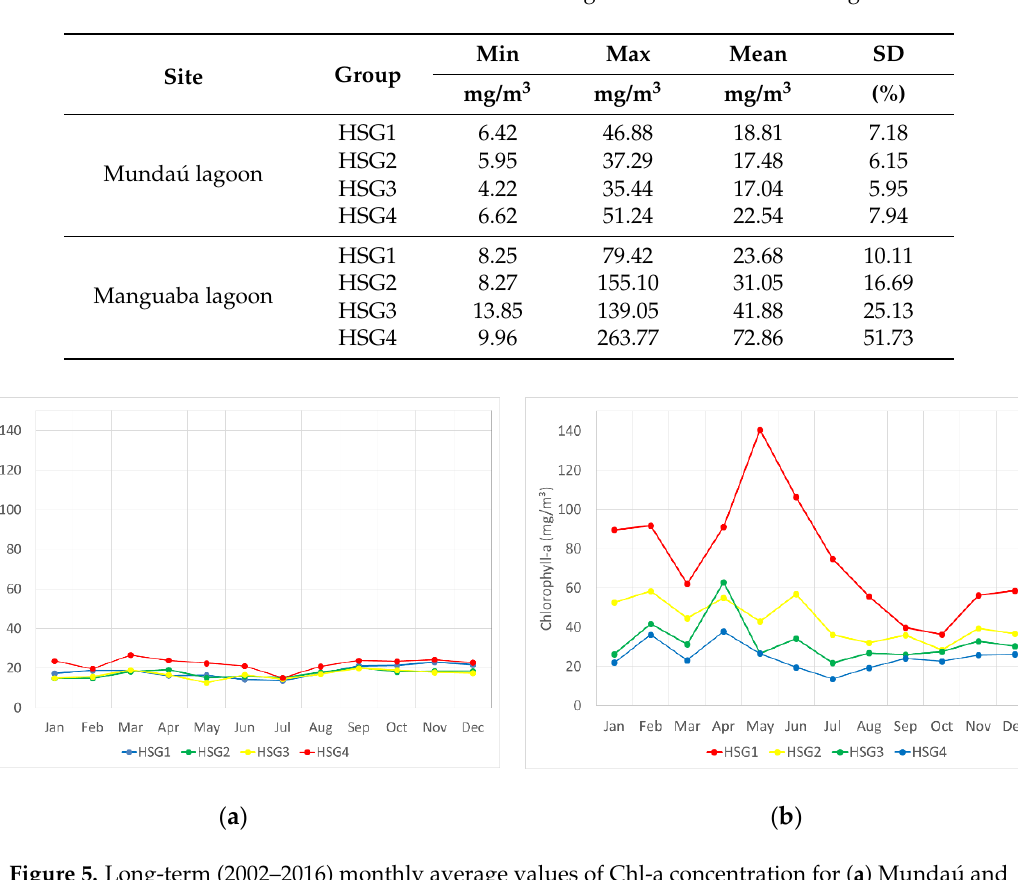
Figure 5. Long-term (2002–2016) monthly average values of Chl-a concentration for ( a ) Mundaú and ( b ) Manguaba lagoons, considering different HSG obtained in the Cluster Analysis.